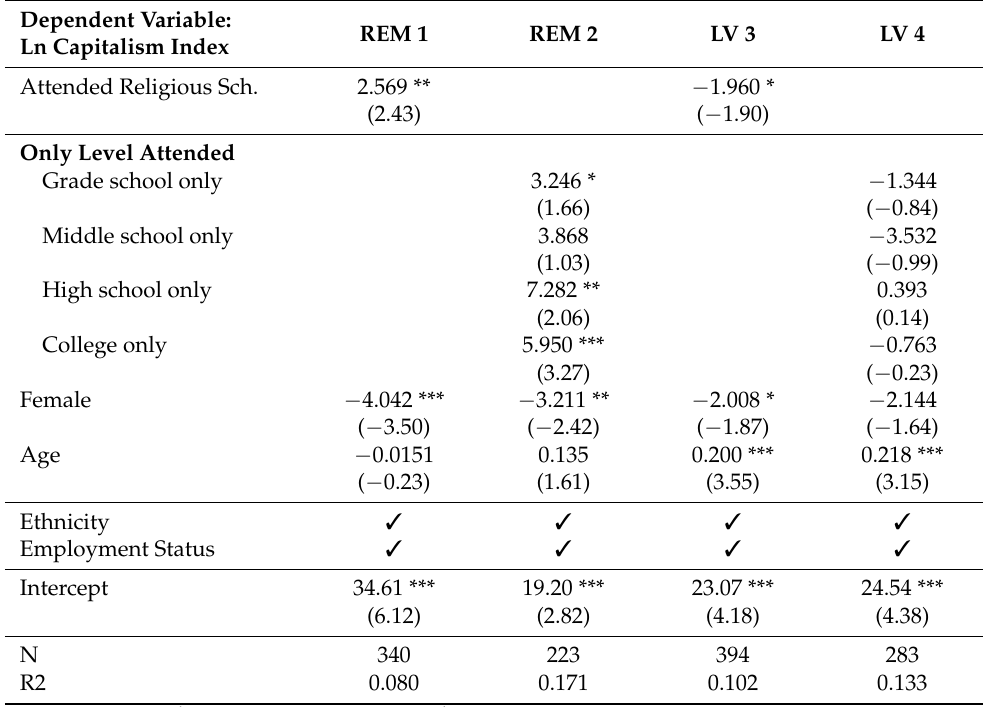
Table 3. Regression results for capitalism index and Catholic education by remainer (REM) versus leaver